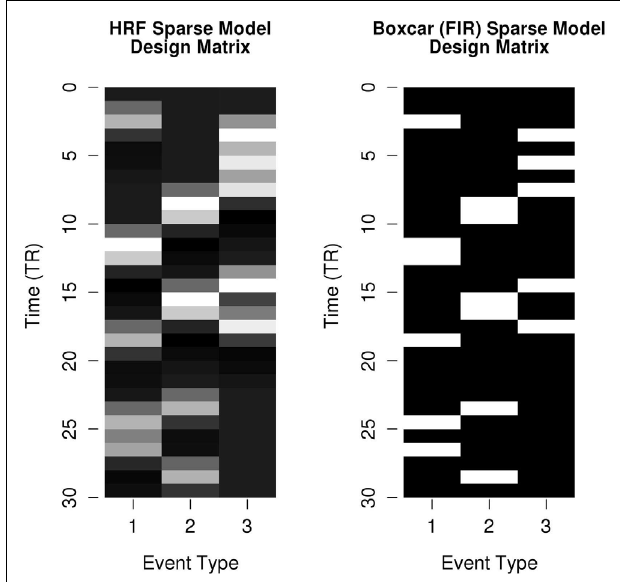
FIGURE 4 | Example design matrices for convolved-HRF or classic boxcar (FIR) sparse models. Design matrices modeling event types of the simulated time series shown in Figure 2 . Design matrix parameters that do not differ between models (overall mean, nuisance variables, etc.) are not